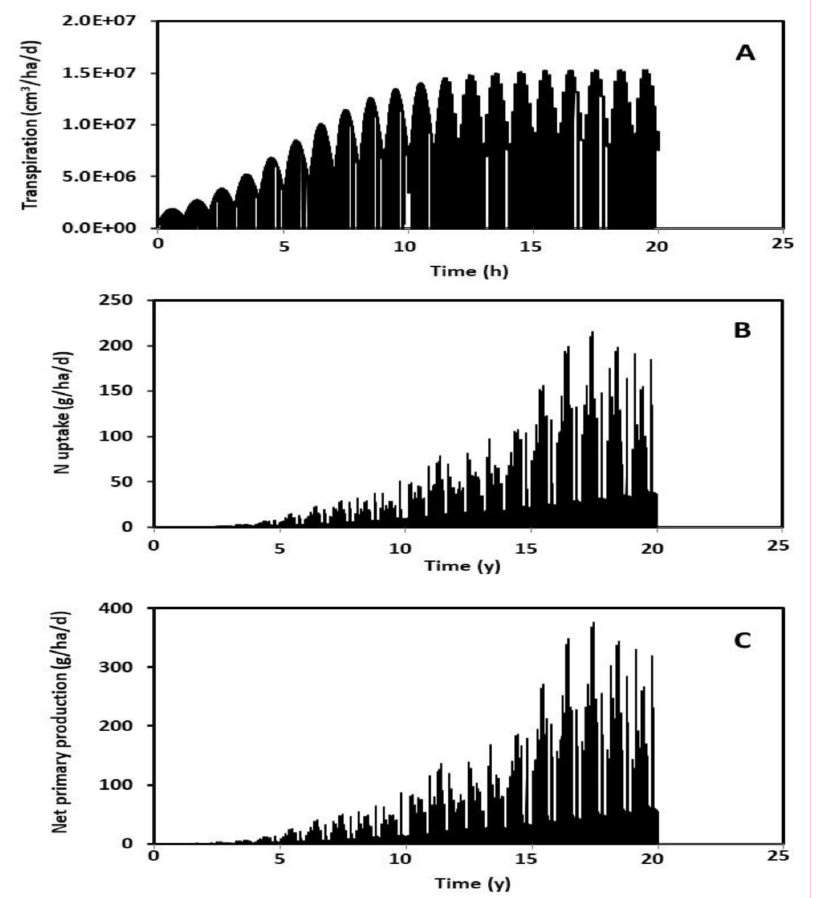
Figure 6. Predicted rates of water use ( A ), N uptake ( B ), and NPP ( C ) during a 20-year simulation